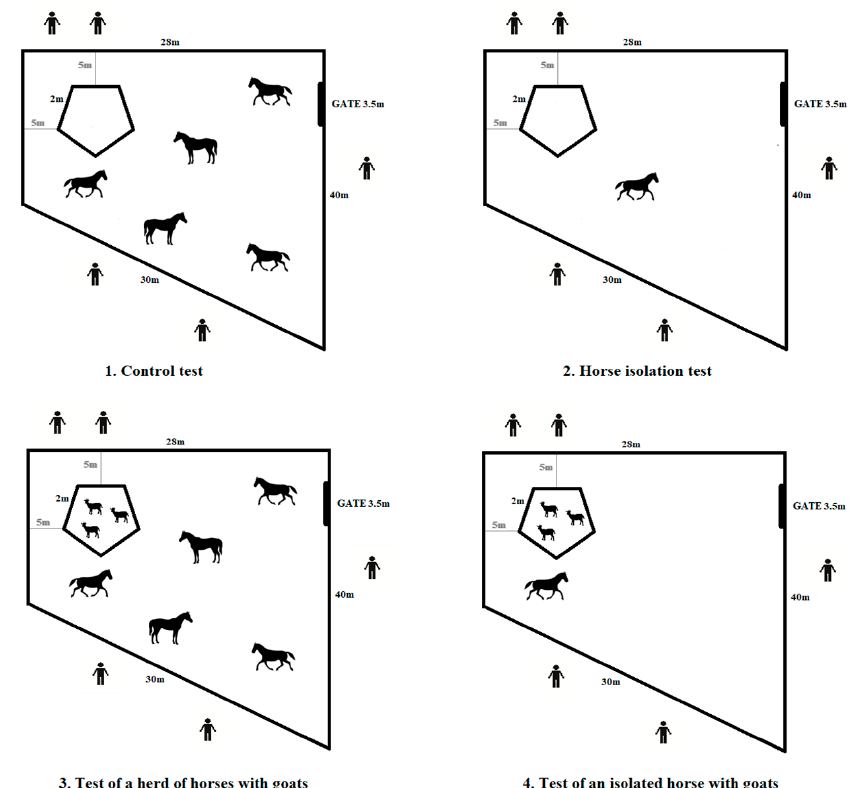
Figure 1. Course of the experiment.